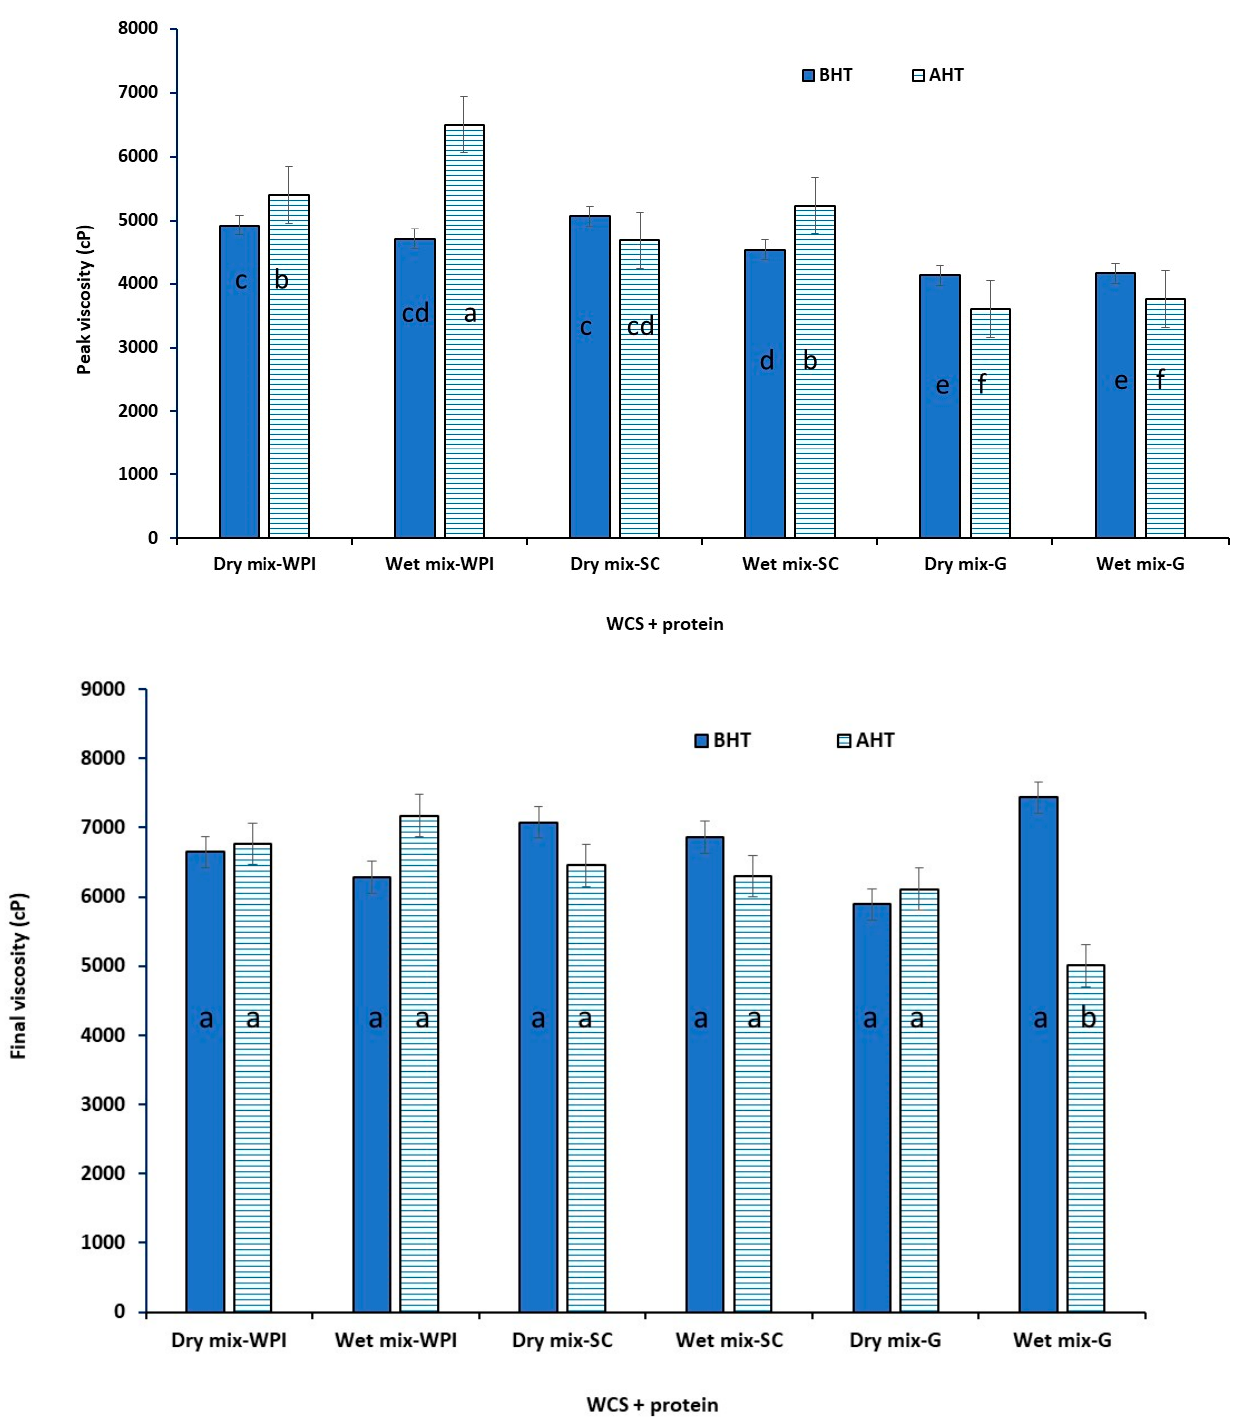
Figure 3. Peak and final viscosity of waxy corn starch (WCS) and protein mixtures before heat treatment (BHT) and after heat treatment (AHT). The different letters on the columns indicate statistically significant differences ( p <